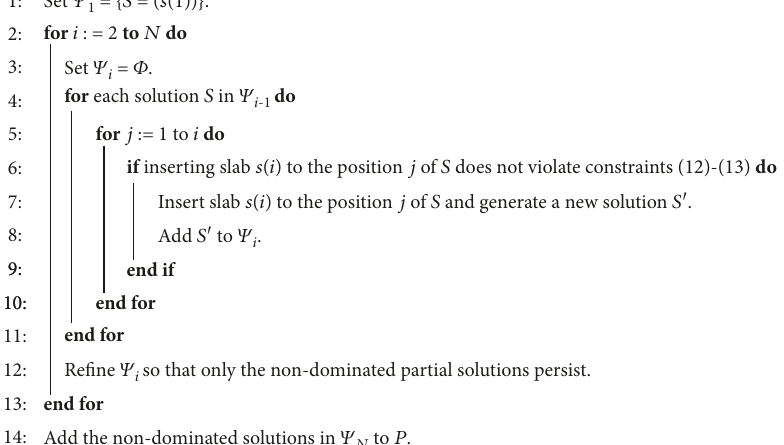
Figure 5: Procedure of the multiobjective